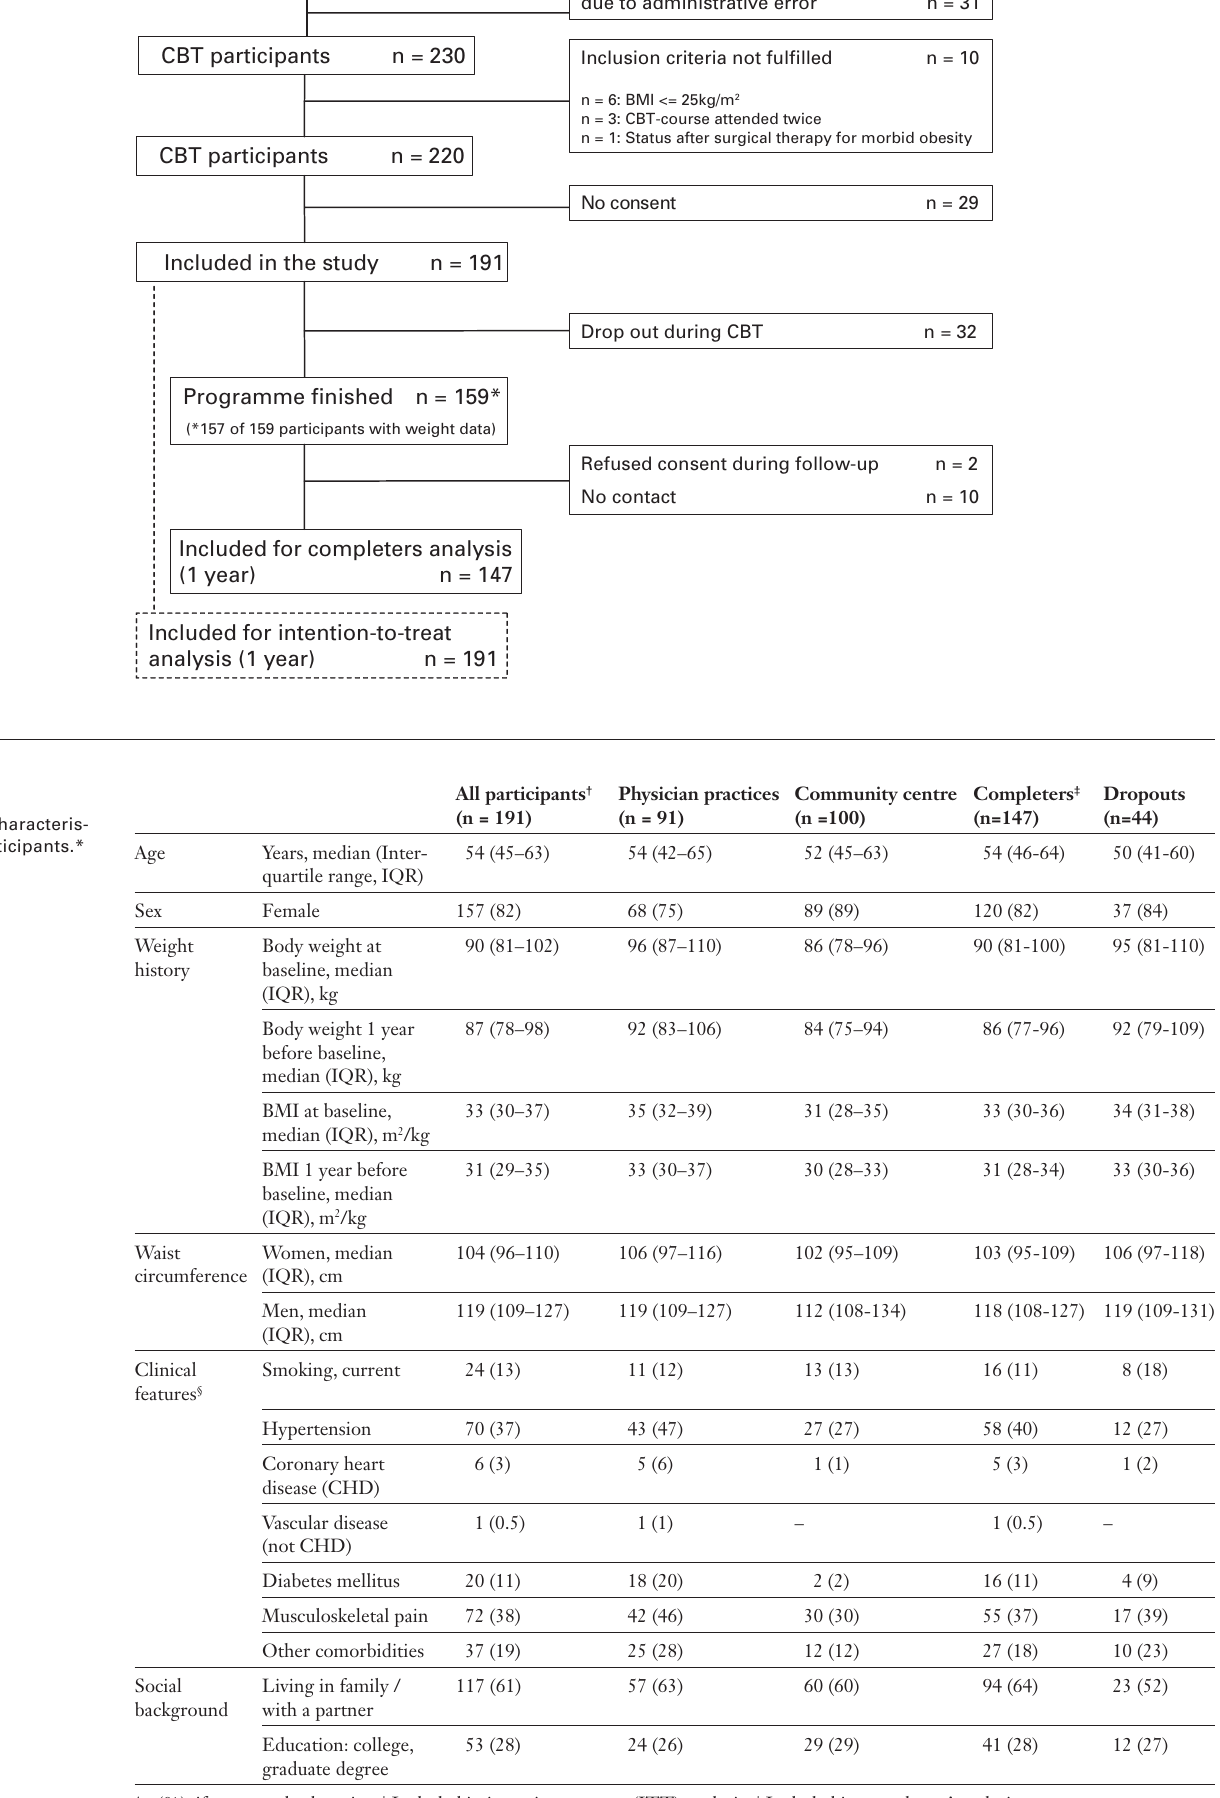
Figure 2 Study flow.